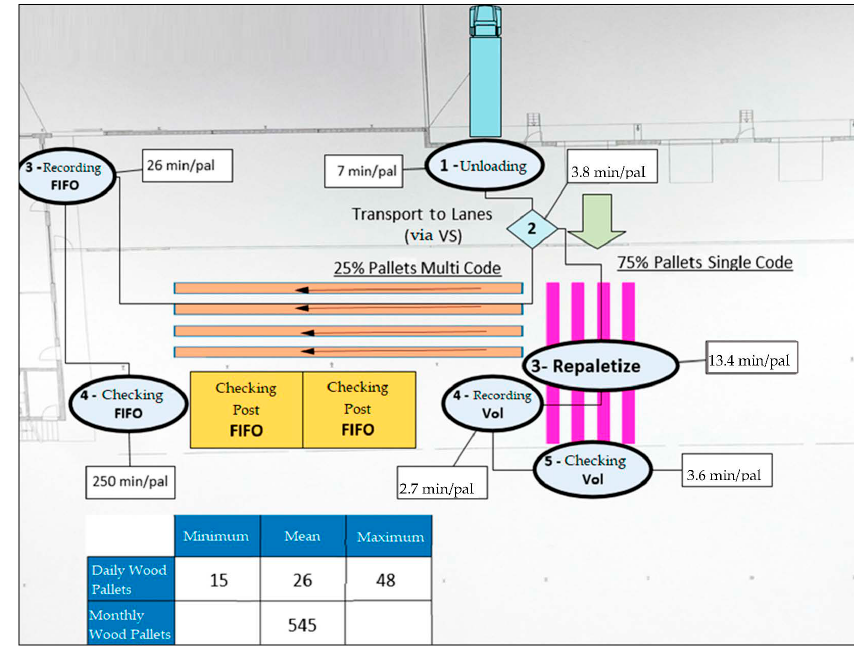
Figure 8. VSM—Palets multi code.